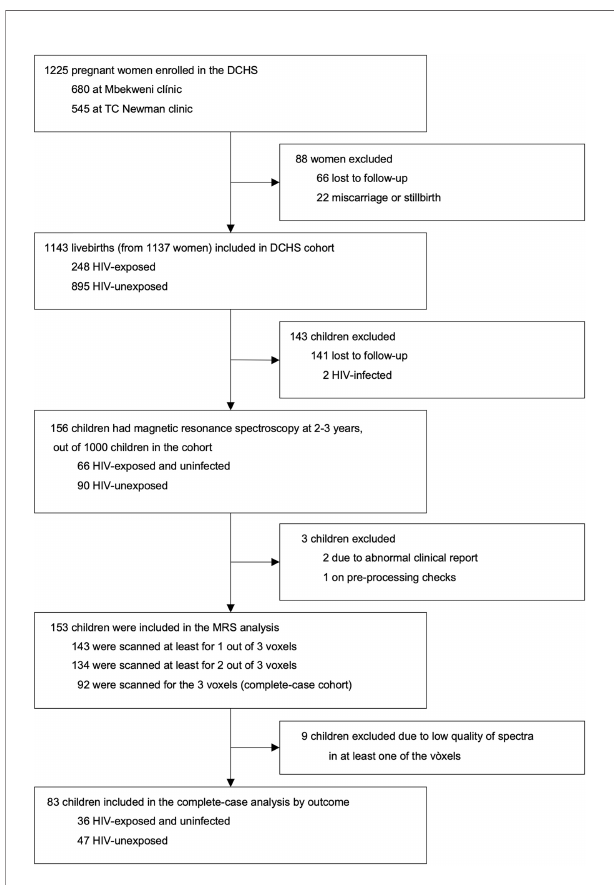
FIGURE 2 | DCHS fl owchart for MRS sub-study. Exclusion criteria for the MRS nested sub-study are described in the methodology